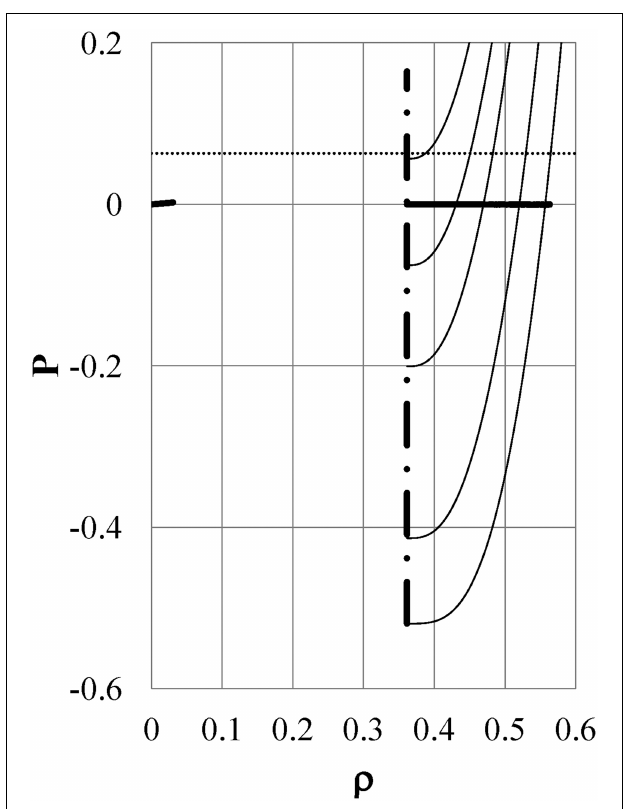
FIGURE 4 | Density-temperature curves for liquid phase at specified pressures for Model φ 2 . Dotted and dashed lines: ρ - T curves at P c = 0 . 0974 and P = 0 . 0341, respectively. Full line: binodal curve. Dot-dash line: spinodal curve. Full circle: the boiling point at P = 0 .